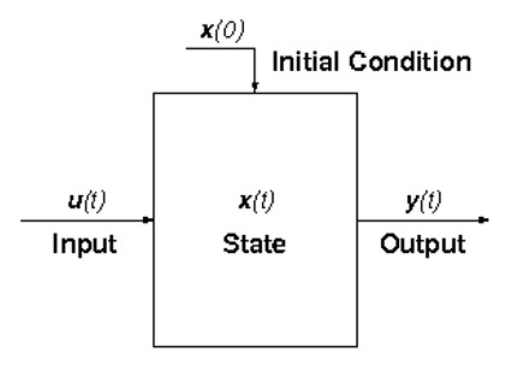
Figure 1. State space modeling concept of the SUT